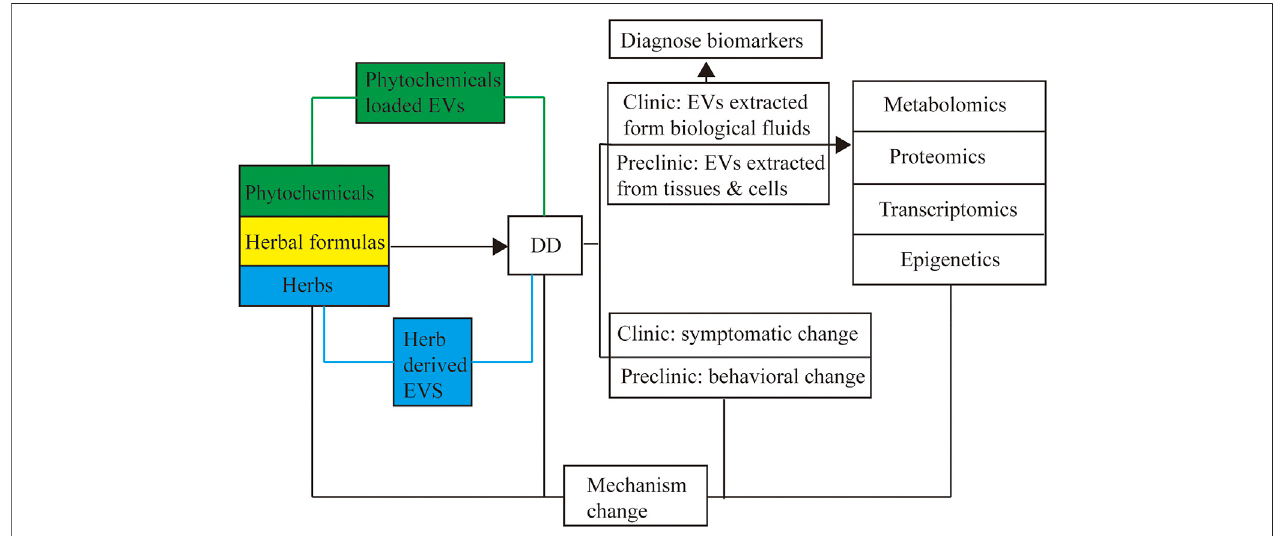
FIGURE4| EVsapplication forCHM.Combinedwithmetabolomics,proteomics,transcriptomics,andepigenetics,extracellularvesiclescanbeappliedtoexplore the mechanism when treating DD with herbal formulas and act as the potential diagnose biomarkers in the clinic and preclinic studies.